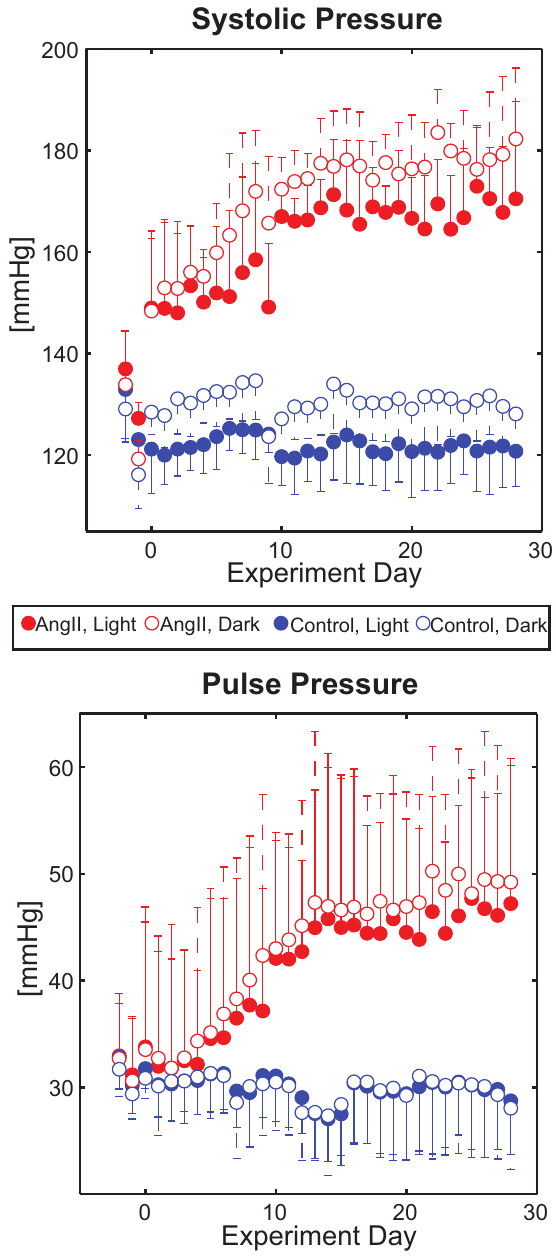
Fig 1. Daily Telemetry Blood Pressure Measurements by Group. Mean and standard deviations for systolic (top) and pulse (bottom) blood pressure via implanted telemetry devices for mice as a function of the number of days they were continuously infused with ‘ AngII ’ (red) or saline ( ‘ Control ’ ; blue). The filled circles represent data recorded during the light cycle; empty circles report data from the dark